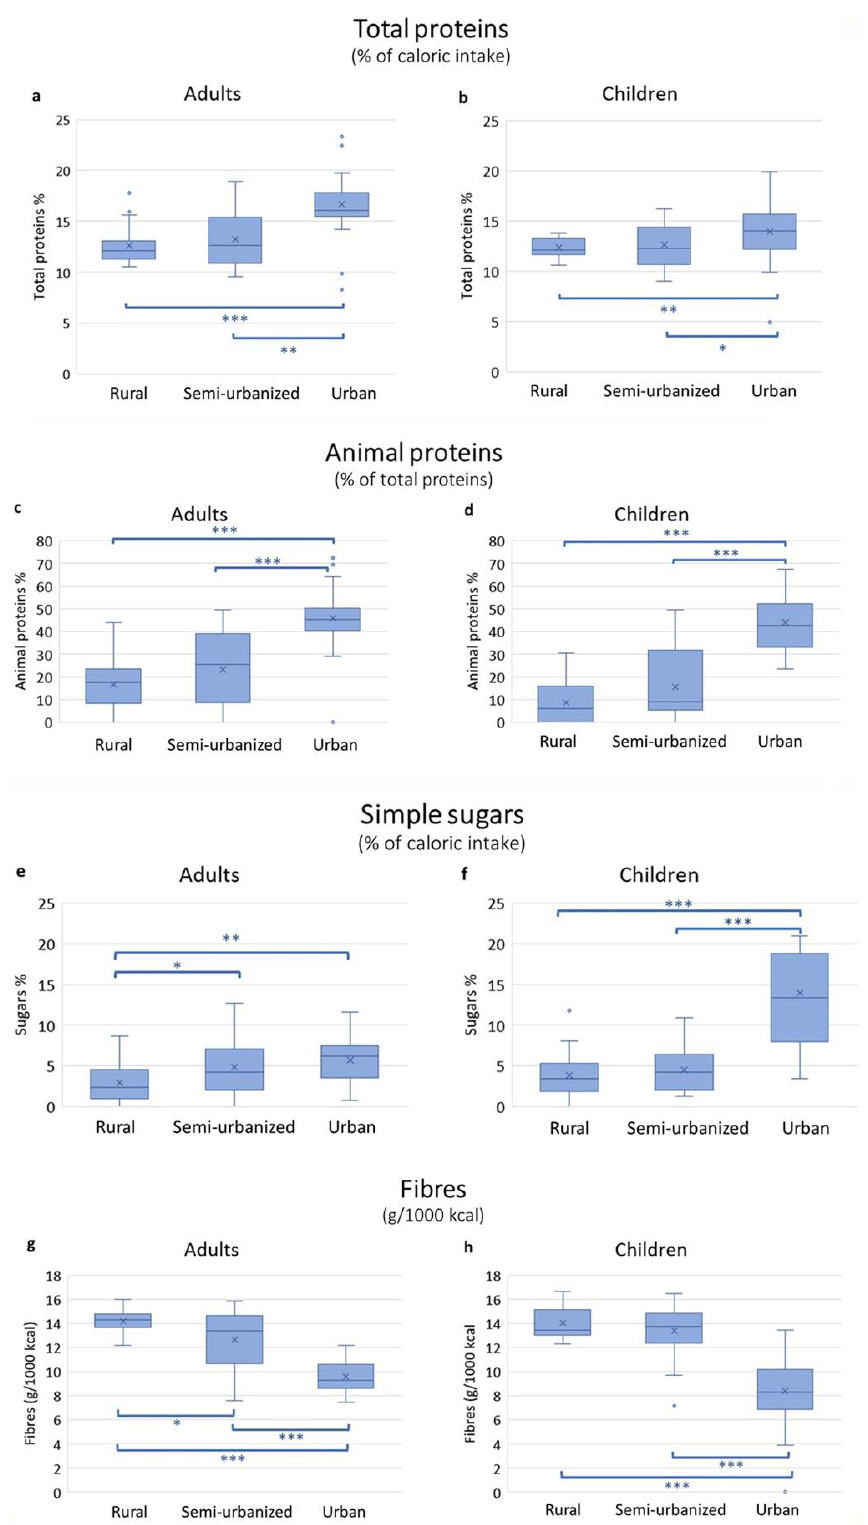
Figure 3. Macronutrient intake in adults and children in the rural, semi-urban and urban areas. The box plots represent median with interquartile range. Total proteins expressed as percentage of total caloric intake in adults ( a ) and children ( b ). Animal proteins as percentage of total proteins in adults ( c ) and children ( d ). Simple sugars expressed as percentage of total caloric intake in adults ( e ) and children ( f ). Fiber intake expressed as grams per 1000 kcal in adults ( g ) and children ( h ). Statistically significant by Mann–Whitney test *** p ≤ 0.001, ** p ≤ 0.01, * p ≤